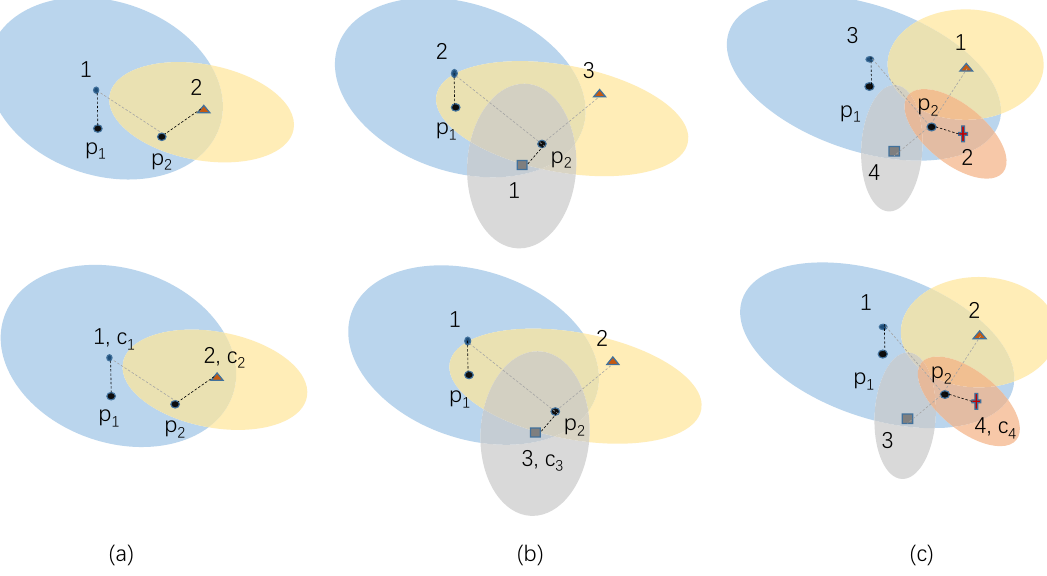
Figure 7. Illustration of clustering vector alignment process, where C 1 , C 2 , . . . denote centroids of clusters with different point annotations, p 1 , p 2 are two example objects, and dashed lines denote distances between p i and C j . The upper figures are original clustering labels of ( a ) K = 2, ( b ) K = 3, and ( c ) K = 4, while the lower figures are relabeled